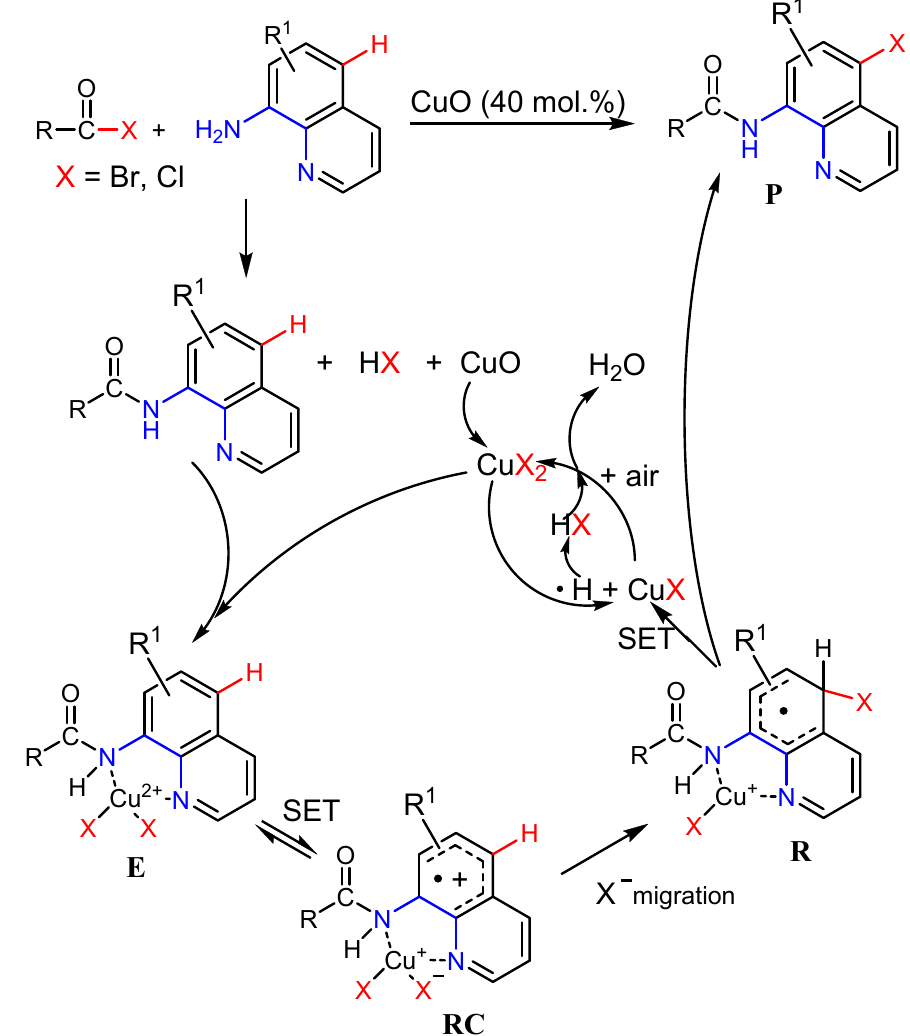
Scheme 12. Acylation of 8-aminoquinoline accompanied by selective Cu-catalyzed